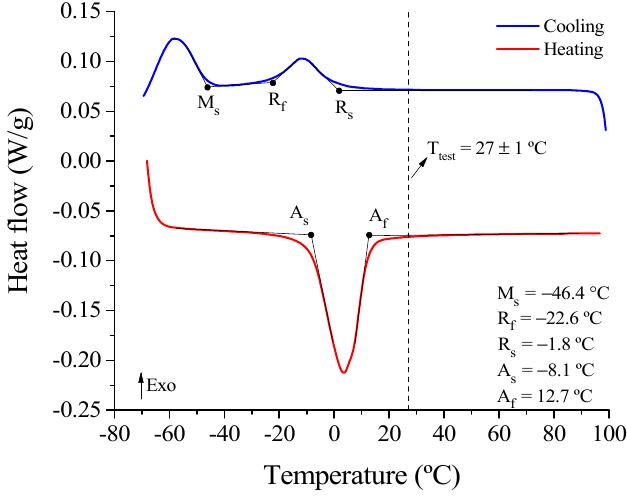
Figure 4. DSC result of the NiTi Belleville spring.